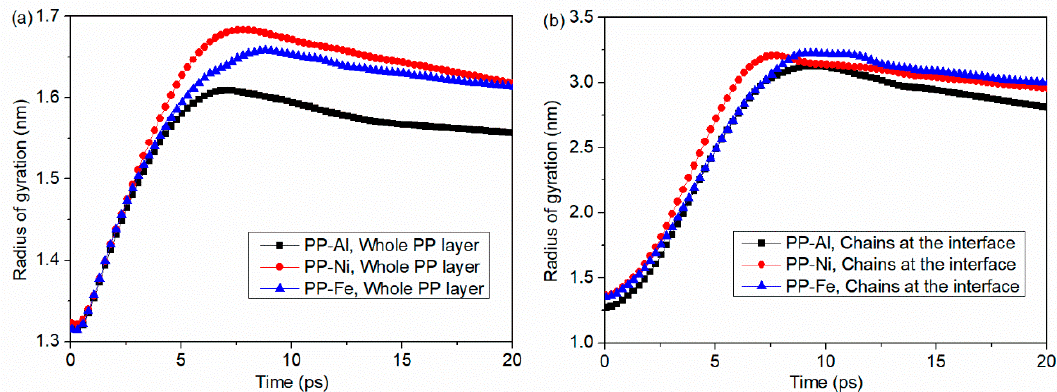
Figure 9. Snapshots of PP-metal hybrid structure during the injection molding and separation process. ( a ) the original PP-metal layer is constructed and then ( b ) injection-molded to form a hybrid system. After cooling process, an external force was applied to remove the PP layer away from the metal substrate. These snapshots are taken at a separation time of 10 ps, with the substrates of ( c ) Al, ( d ) Ni and ( e ) Fe, respectively.